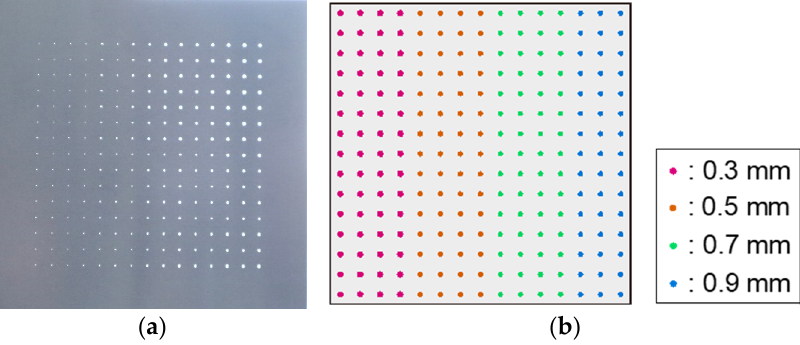
Figure 3. ( a ) Photograph of specimen (C); ( b ) profile sketch of specimen (C). - Specimen (D): As shown in Figure 4, specimen (D) consists of five different hole diameters, 0.3, 0.5, 0.7, 0.9, and 1.1 mm, arranged from the center to the periphery, with the diameter increasing as one moves towards the outside. The numbers of the holes are: 4 (0.3 mm), 12 (0.5 mm), 20 (0.7 mm), 28 (0.9 mm), and 36 (1.1 mm).